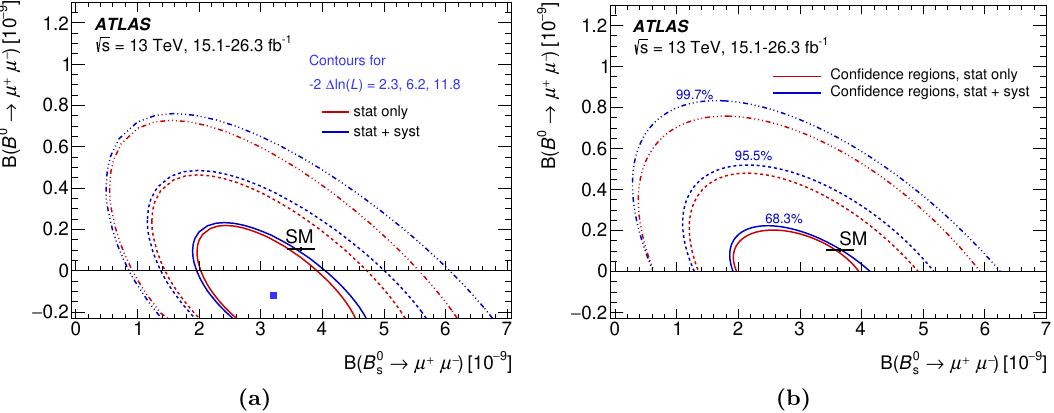
Figure 9. (a) Likelihood contours for the simultaneous (cid:12)t to B ( B 0 ! (cid:22) + (cid:22) (cid:0) ) and B ( B 0 ! (cid:22) + (cid:22) (cid:0) ), s for values of (cid:0) 2(cid:1) ln ( L ) equal to 2.3, 6.2 and 11.8. The SM prediction with uncertainties is indicated. (b) Neyman contours in the B ( B 0 ! (cid:22) + (cid:22) (cid:0) )- B ( B 0 ! (cid:22) + (cid:22) (cid:0) ) plane for 68.3%, 95.5% and 99.7% s coverage. At each (cid:0) 2(cid:1) ln ( L ) or coverage value, the inner contours are statistical uncertainty only, while the outer ones include statistical and systematic uncertainties. The construction of these contours makes use of both the dimuon (26.3 fb (cid:0) 1 ) and the reference channel (15.1 fb (cid:0) 1 ) datasets.